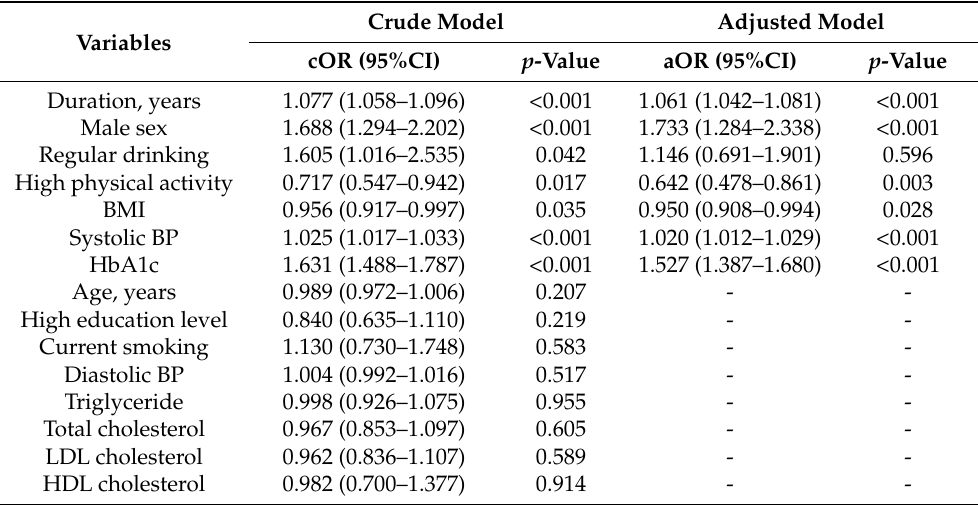
Table 3. Risk factors associated with diabetic retinopathy in hypertensive patients with